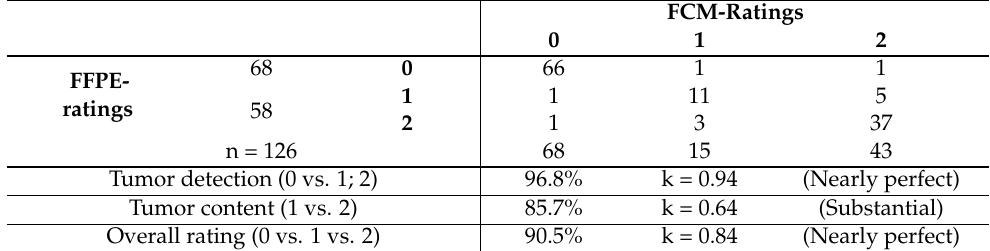
Table 1. Comparison of the FCM ratings and the histological examination of the biobank samples. FCM-Ratings 0 1 2 68 0 66 1 1 FFPE- 1 1 11 5 ratings 58 2 1 3 37 n = 126 68 15 43 Tumor detection (0 vs. 1; 2) 96.8% k = 0.94 (Nearly perfect) Tumor content (1 vs. 2) 85.7% k = 0.64 (Substantial) Overall rating (0 vs. 1 vs. 2) 90.5% k = 0.84 (Nearly